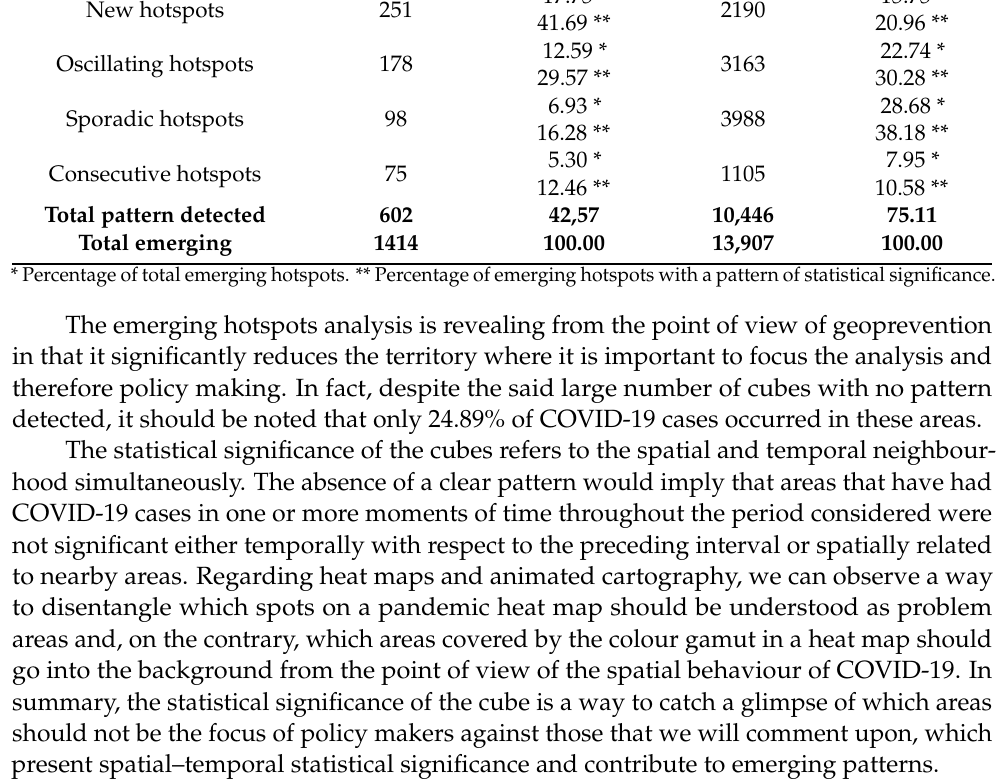
Number of % Cases